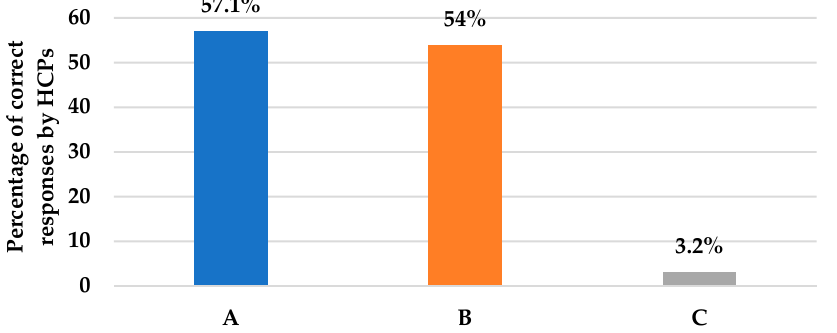
Figure 3. This figure illustrates the percentages of HCPs’ correct answers for questions assessing de-escalation to a targeted antifungal in three different case scenarios, as presented in questions 6, 7, and 8, respectively. (A): Action if culture results were C. Albicans ; 57.1% answered de-escalation to